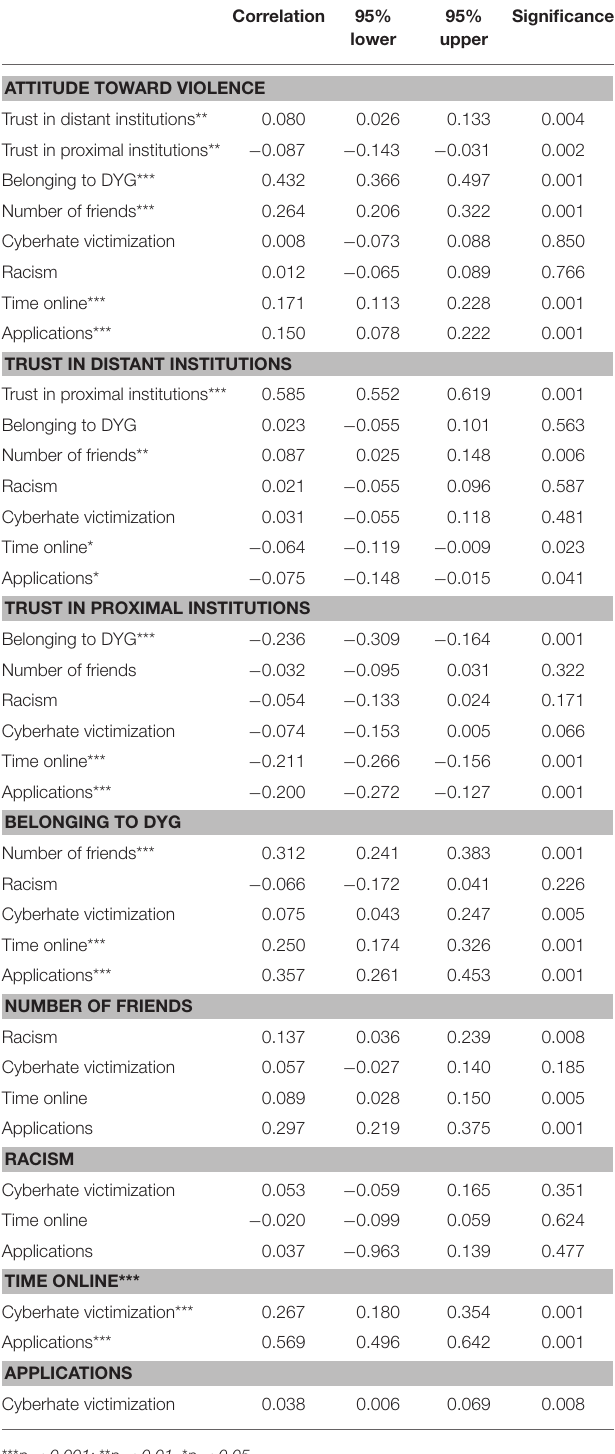
TABLE 7 | Correlation coefficients between latent